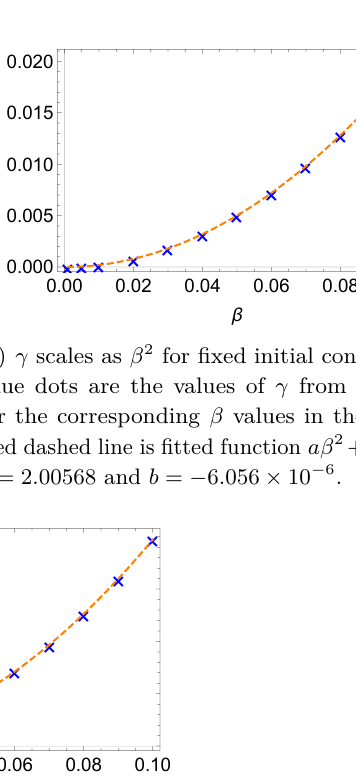
(c) E max scales as β 2 for fixed initial con- ditions. Blue dots are the values of E max from table 1 for the corresponding β values in the table. Red dashed line is fitted function